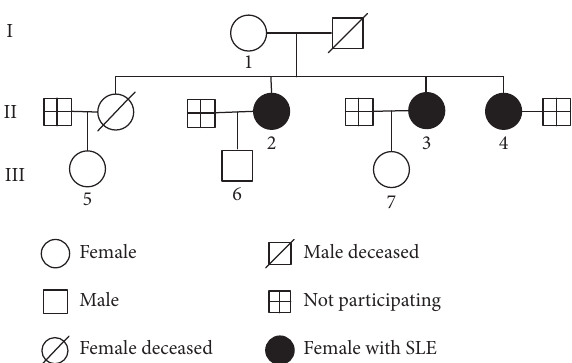
Figure 1: Pedigree diagram of the SLE family. Pedigree diagram of the SLE family with 3 SLE sisters diagnosed at the age of 27; the 3 patients’ mother was RF positive and was suspected to have an autoimmune disease (AID). The deceased elder sister was diagnosed with clinical signs of SLE.